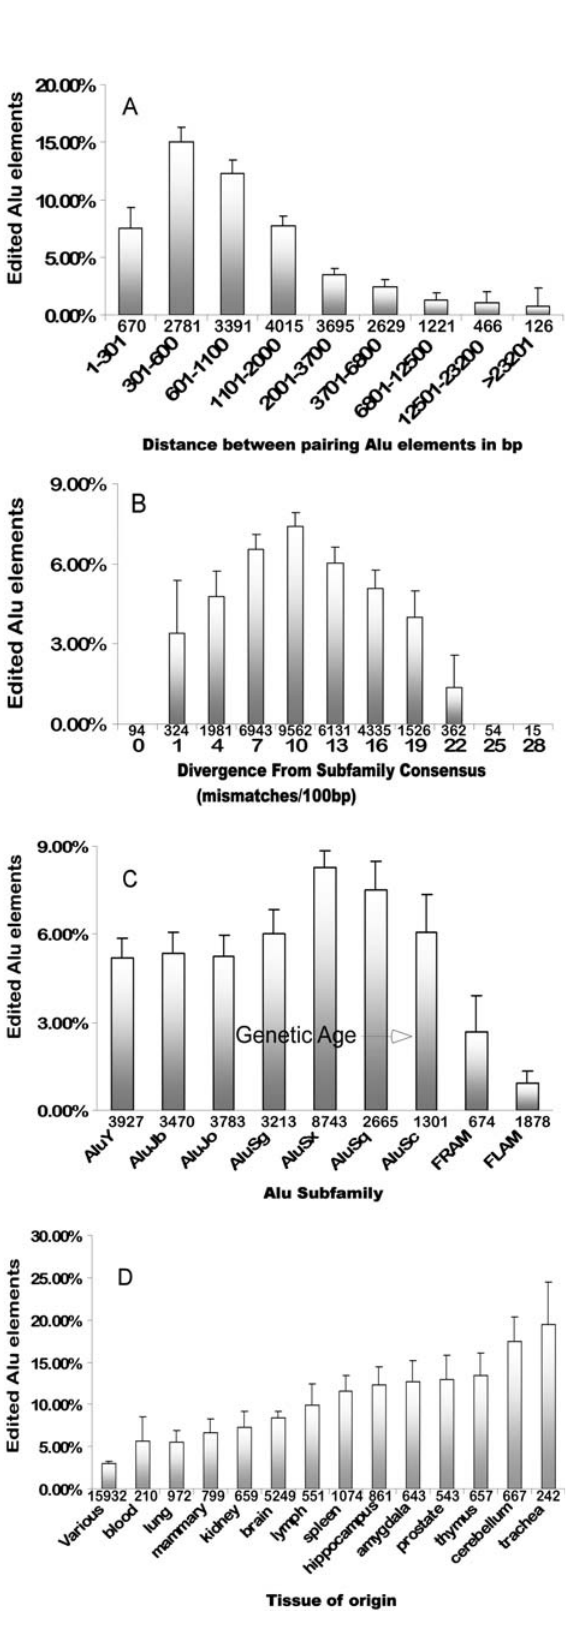
Figure 7. Factors Determining Alu Targeting Probability (A) Percentage of edited elements classified in bins according to the distance separating the element and its closest inverted Alu partner. (B) Percentage of edited Alu elements clustered according to divergence from their corresponding Alu-subfamily